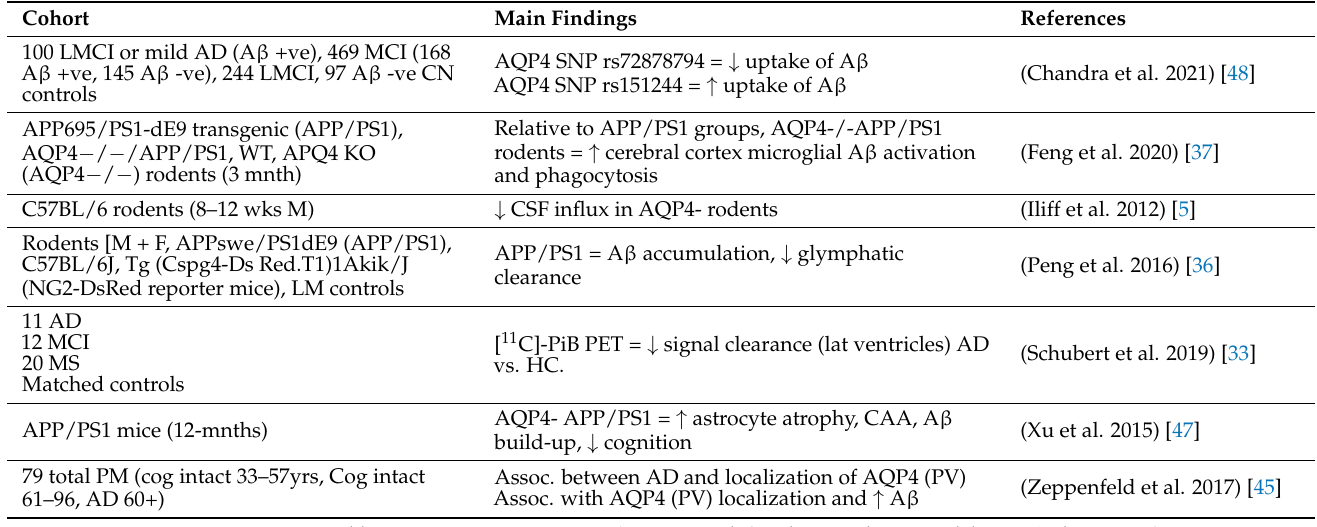
Table 1. Summary of findings of investigation of the glymphatic system in both human and animal AD